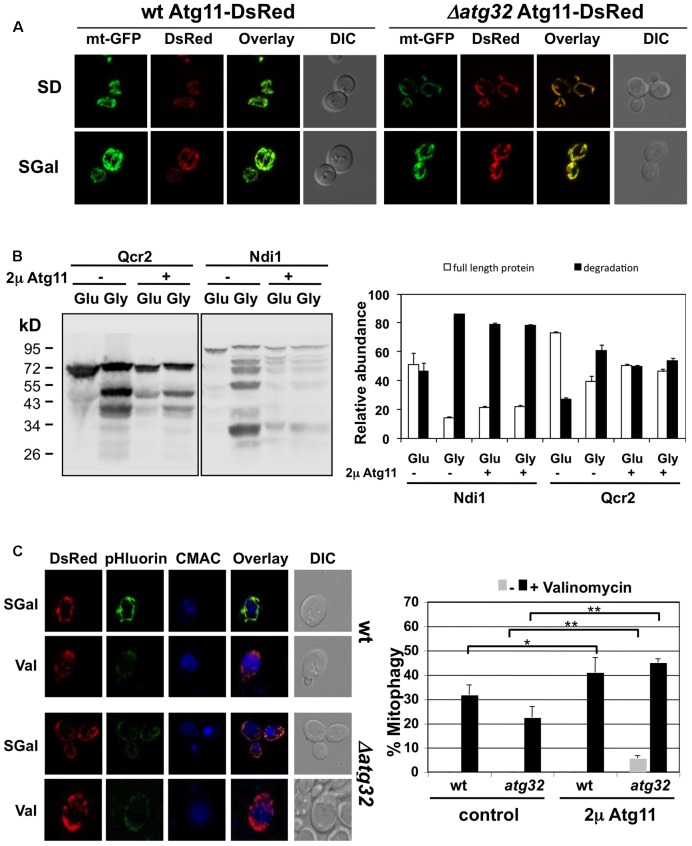
Effects of constitutive Atg11 targeting to mitochondria. (A) Constitutive overexpression leads to Atg11 association with mitochondria. Atg11-dsRed was overexpressed in yeast wild type or atg32 mutant cells harboring mtGFP. The mitochondrial network was visualized by GFP fluorescence, while Atg11 was visualized by dsRed upon fermentative (SD) and partially respiratory (SGal) growth conditions. (B) Qcr2 and Ndi1 protein degradation was assessed by western blot using chromosomally expressed TAP-fusions. Cells overexpressed the Atg11-dsRed fusion protein or contained the empty vector as indicated. Quantification of the ratio of full length and degradation products of the Qcr2 and Ndi1 proteins is shown in the right panel. The standard error is shown based on three independent experiments. (C) Constitutive Atg11 expression reverts mitophagy defects of atg32 mutants, but does not lead to constitutive mitophagy induction. The mitophagy indicator Rosella was used in yeast wild type and atg32 mutant strains in the presence or absence of Atg11 overexpression. Cells were grown in selective galactose containing (SGal) media and then treated with valinomycin (4 μM) for 2 h. Representative micrographs are shown for the Atg11 overexpression strains at the left. mtRosella was visualized by dsRed or pHluorin fluorescence, vacuoles were visualized with CMAC. The percentage of mitophagy positive cells was determined from >50 individual cells in two independent experiments. The mean values including the standard error are indicated in the right panel. Significant changes in the rate of mitophagy positive cells are marked: ∗p < 0.05; ∗∗p < 0.01 (Student’s t-test).